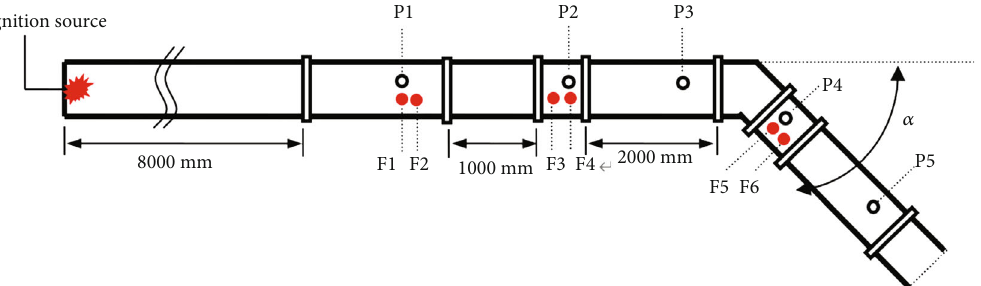
Figure 4: Sketch map of the bend pipe.